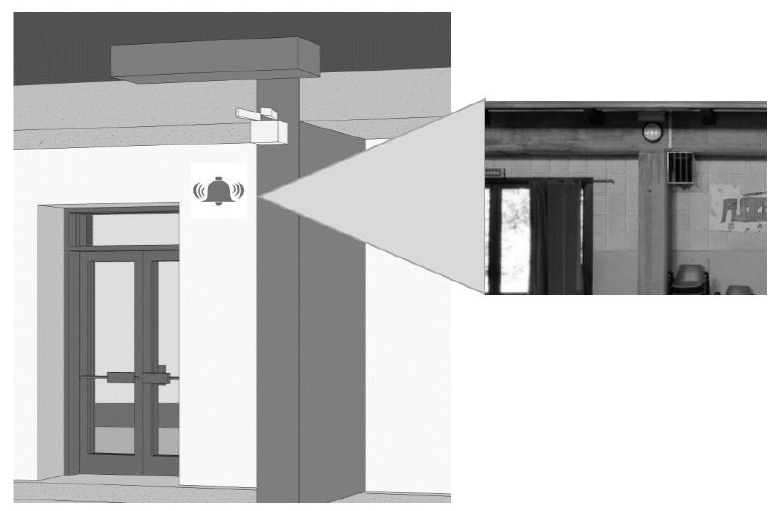
Figure 8. Building information model fault message reporting interface.